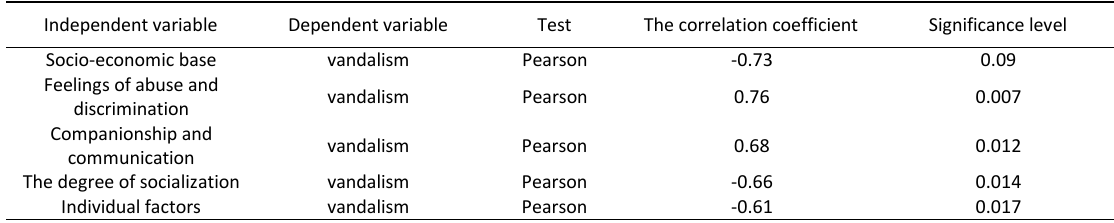
Table 5: One-by-one correlation test of independent variables with dependent variables